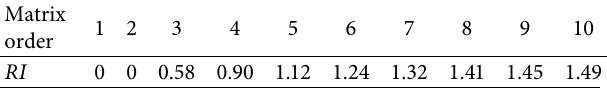
Table 2: Average random consistency index.